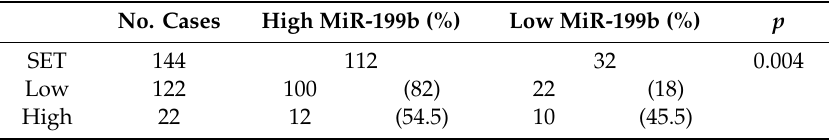
Table 2. Association between miR-199b and SET in 144 early-stage CRC patients.